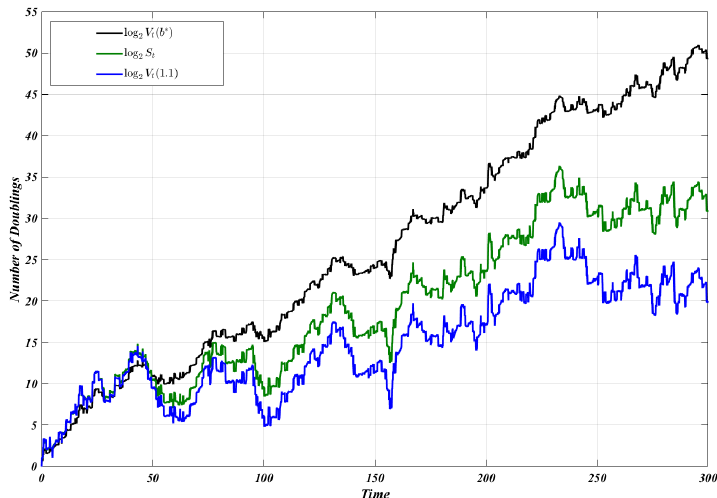
Figure 2. A sample path in the large. ν : = 0.07, σ : = 0.15, r : = 0.03, λ : = 1, b : = 0.585, c : = 1, d : = 1.1, x ∈ { + 100%, − 50% } , T : =